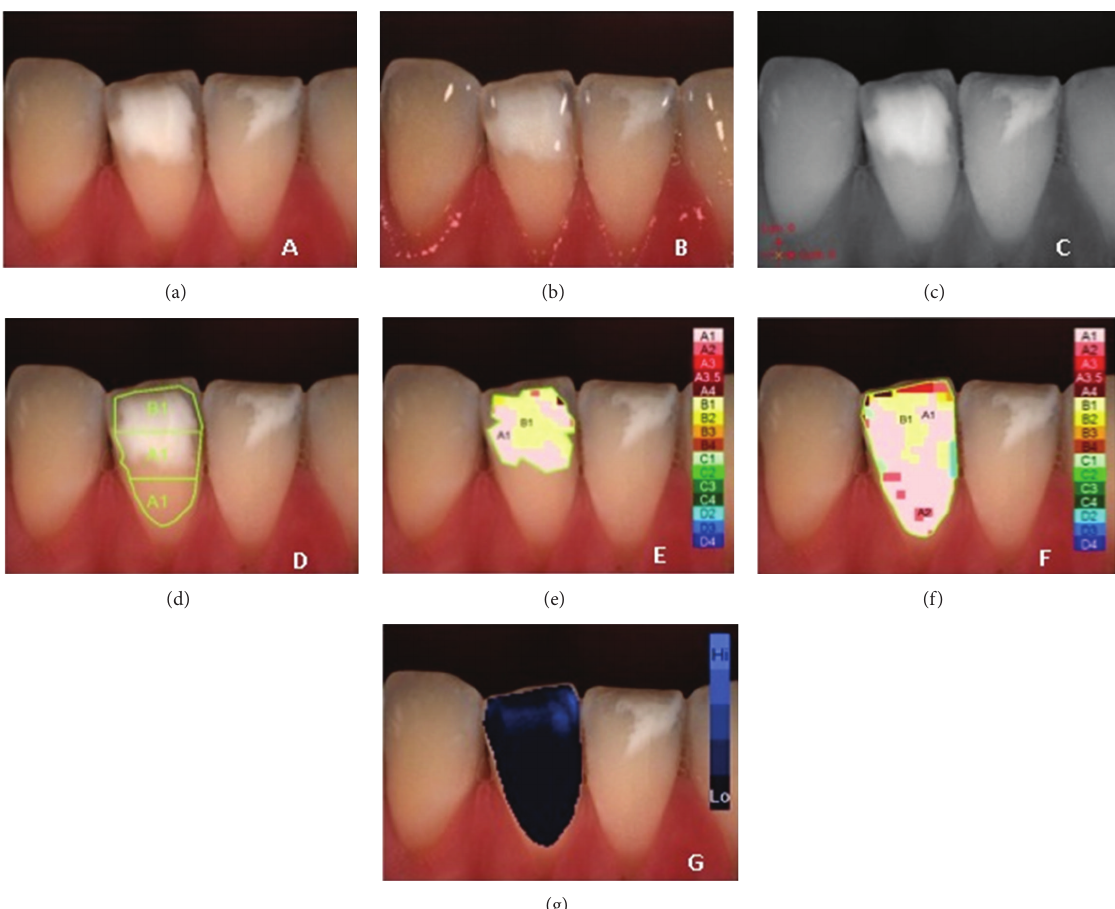
Figure2:Exampleof 𝐿 ∗ 𝑎 ∗ 𝑏 ∗ measurementsofdemarcatedopacityonlowercentralrightincisor:(a)polarizedimage;(b)glossmodeallowing the identification of “pure enamel zones”; (c) contrast image; (d) evaluation of the three equal zones along the median axis: gingival, central, and incisal; (e) colour distribution and detailed mapping of the defect surface; (f) overall detailed mapping; (g)